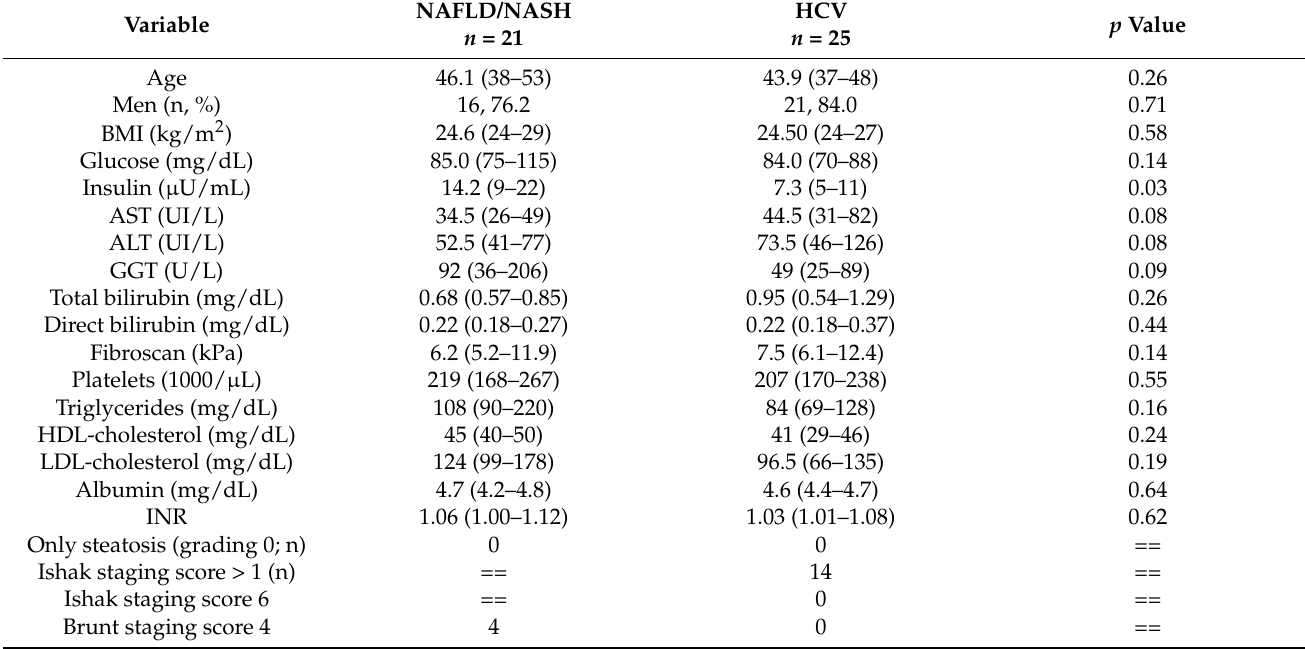
Table 2. Clinical characteristics and biochemical parameters of the study